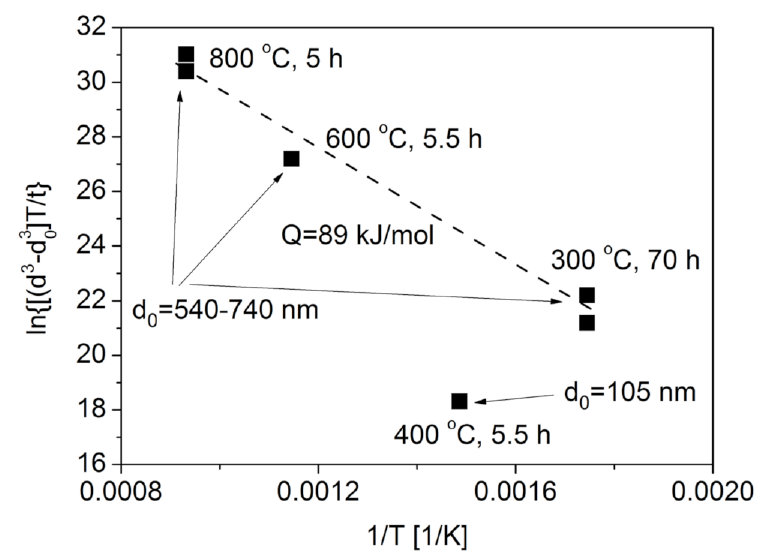
(cid:8)(cid:2) (cid:3) (cid:9) d 3 − d 3 T / t Figure 3. A plot of ln versus 1/T used to determine the activation energy of the 0 mechanism behind ligament coarsening in Cu foams processed by dealloying and subsequently annealed under an inert atmosphere. The plotting was performed based on Equation (3). The grain sizes ( d and d 0 ) were taken in nanometres, while the units of t and T were hours and Kelvin degrees,